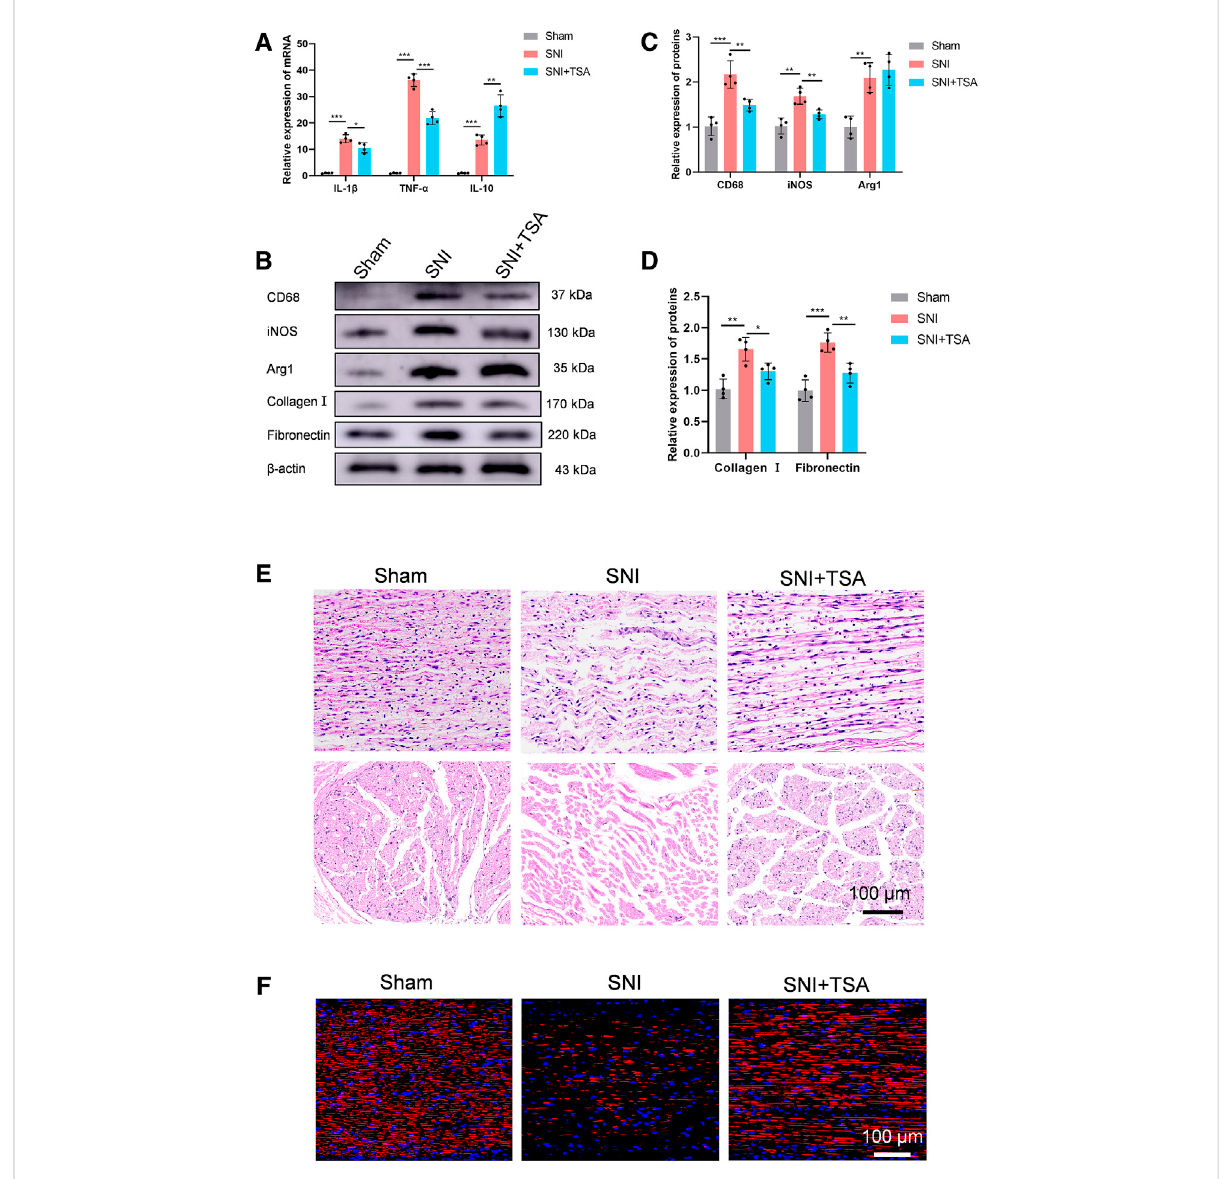
FIGURE 6 TSAinhibitsneuralin fl ammationandscarringandenhancesPNRfollowingSNI. (A) TherelativeIL-1 β ,TNF α ,andIL-10expressioninDRGonday 14postoperation,asevidencedbyreal-timeqPCR. (B) ProteinexpressioninDRGtissuesatday14postSNI,asevidencedbywesternblotanalysis. (C) Protein data quanti fi cation from (B) . (D) Protein data quanti fi cation from (B) . (E) H&E staining of regenerated axons at the nerve segment in each groupat4 weekspostinjury. (F) GAP43(red)andDAPI(blue)stainingofregeneratedaxonsatthenervesegmentofindividualgroupsat4weeks post SNI. Data are provided as mean ± SD, with n = 4 per group. * p < 0.05, ** p < 0.01, and *** p < 0.001 are deemed signi fi